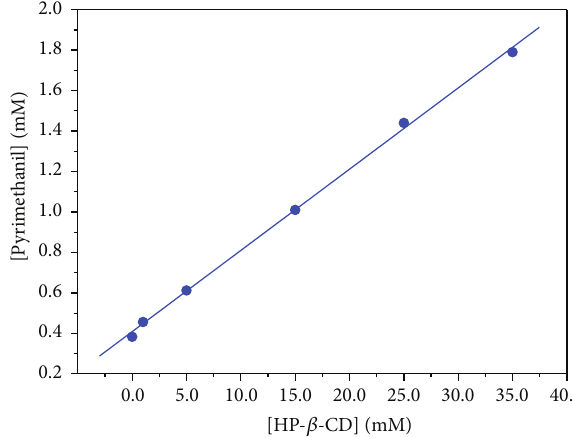
Figure 2: Phase solubility diagram obtained for fungicide pyrimethanil and increasing concentrations of HP- 𝛽 -CD in water at 25 ∘ C. Each point represents the mean of three